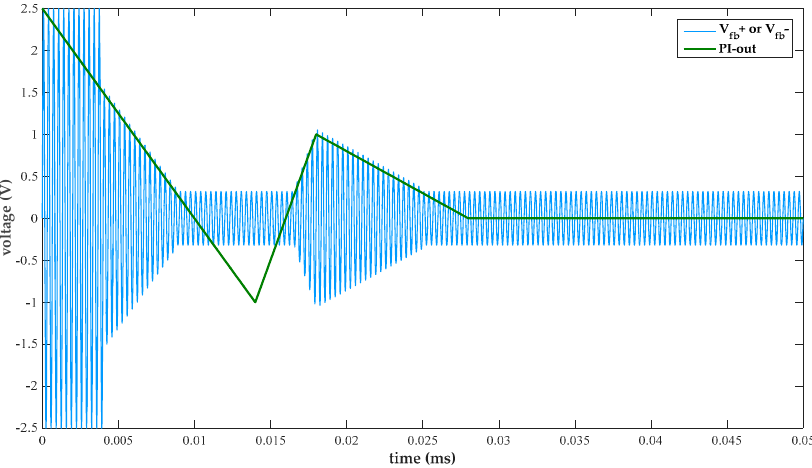
Figure 7. Transient simulation of the proposed nonlinear multiplier.